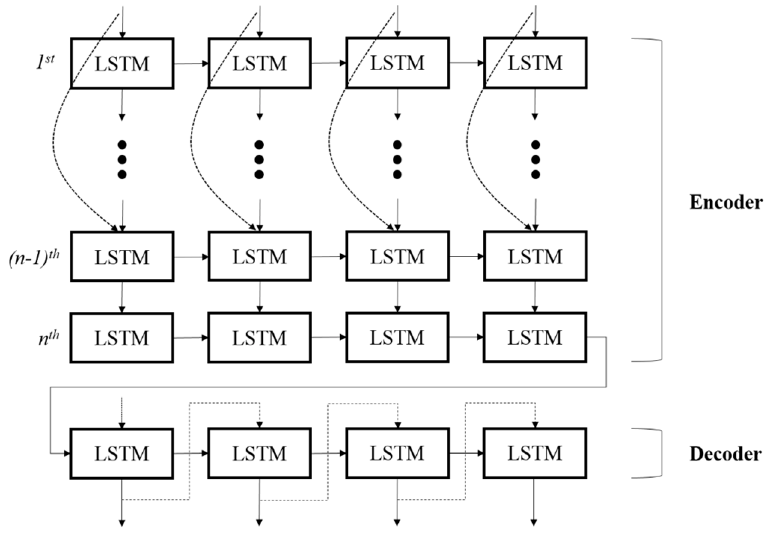
Figure 7. Proposed network when multimodal features are available.